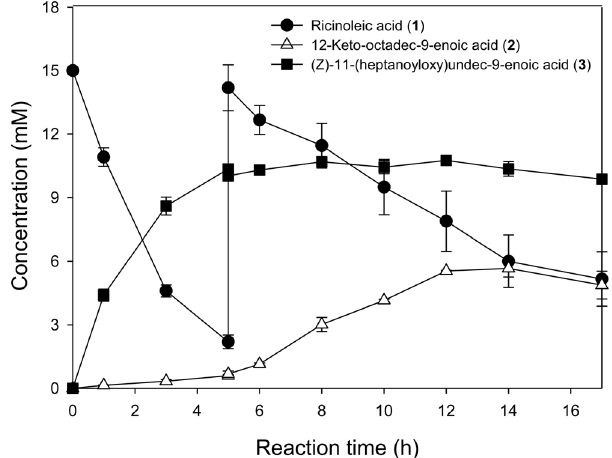
Figure 1. Time course of the biotransformation of ricinoleic acid by the recombinant E . coli BL21(DE3) pAPTm-E6BVMO-ADH, expressing an alcohol dehydrogenase (ADH) of Micrococcus luteus and the engineered Baeyer-Villiger monooxygenase (BVMO) from Pseudomonas putida KT2440 (i.e., E6BVMO). The biotransformation was initiated by adding 15 mM ricinoleic acid and 0.5 g/L Tween80 at t = 0 into the recombinant E . coli culture broth (cell density: 3 g cell dry weight (CDW)/L). Ricinoleic acid was added once more to a concentration of 15 mM at t = 5 h. Symbols indicate the concentrations of ricinoleic acid ( 1 ) ( ● ), 12-keto-octadec-9-enoic acid ( 2 ) ( △ ), and the ester (3 ) ( ■ ). The experiments were performed in triplicate. The error bars indicate standard